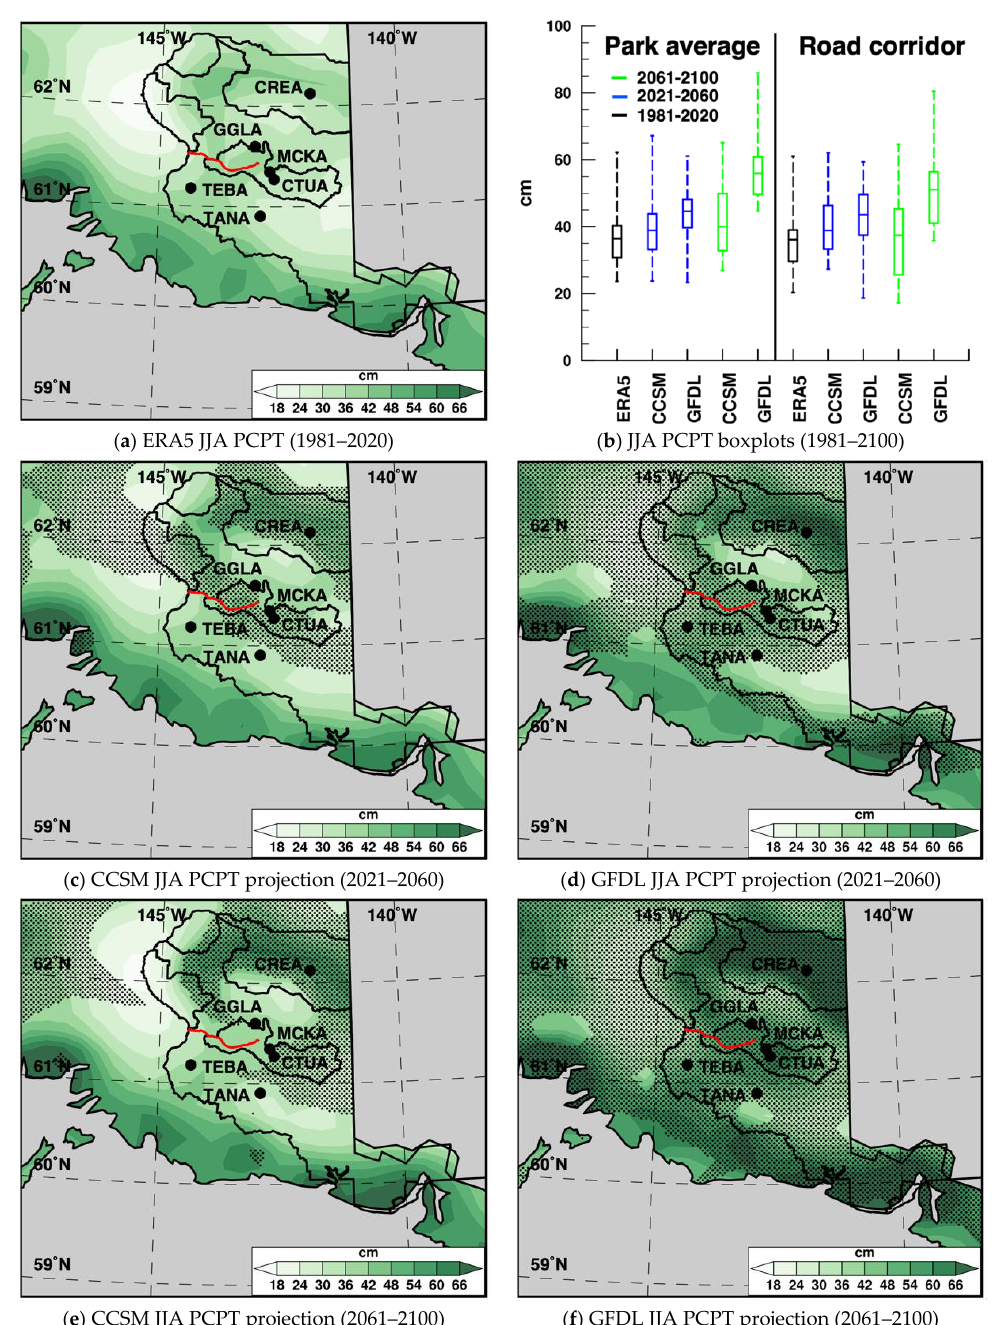
Figure 11. Wrangell-St. Elias ( a ) ERA5 summer precipitation (JJA PCPT) climatology (cm), ( b ) park- average (left) and road corridor (right) boxplots of MAAT, and bias-corrected: mid-century MAAT projections from ( c ) CCSM and ( d ) GFDL and late-century MAAT projections from ( e ) CCSM and ( f ) GFDL. Projected changes at the 95% confidence level are shaded with